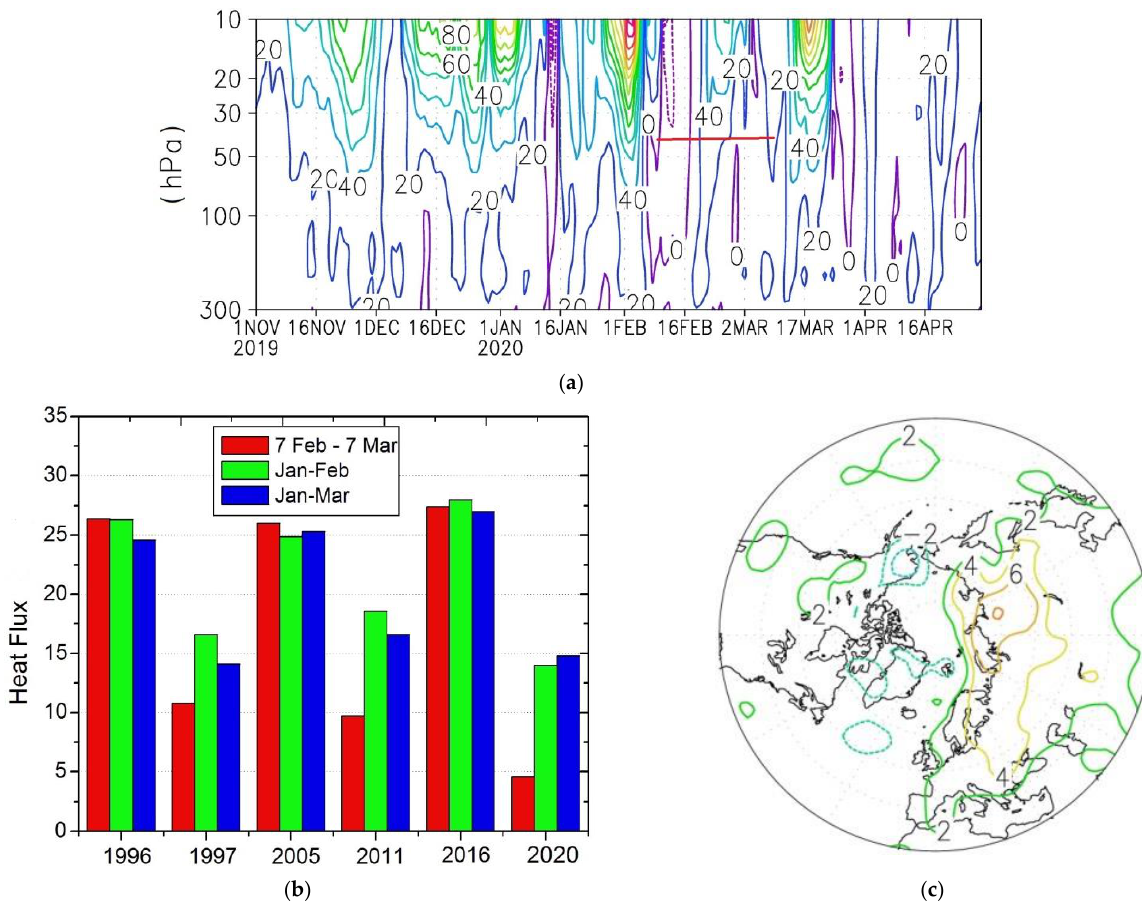
Figure 3. Zonal mean meridional heat flux (К m/s) averaged over 45–75° N from 1 November 2019 to 30 April 2020. The period of reduced upward wave activity propagation is marked by a red horizontal line ( a ). Zonal mean meridional heat flux (К m/s) at 70 hPa averaged over 45–75° N and the following periods: from 7 February to 7 March, from 1 January to 28 February, from 1 January to 31 March of 1996, 1997, 2005, 2011, 2016, and 2020 ( b ). Temperature anomalies (K) at 925 hPa averaged over the period from 7 February to 7 March 2020. Solid contours correspond to positive values, dashed - negative. Zero contour is omitted. Contour interval is 2. The map shows only latitudes north of 30°N ( c ).